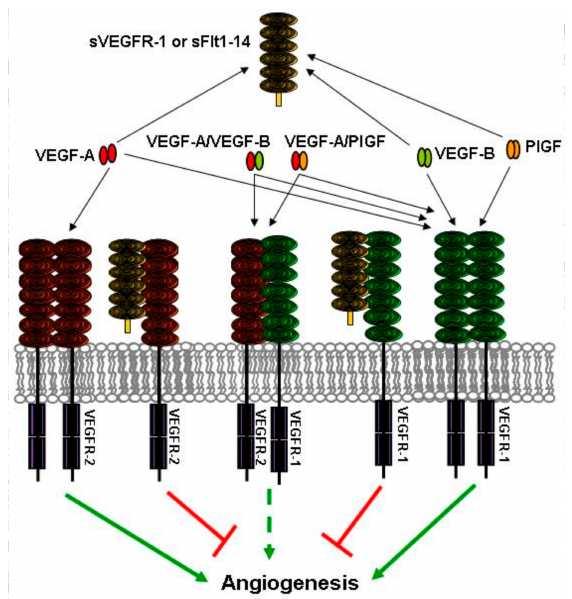
Figure 1. Anti-angiogenic roles of soluble vascular endothelial growth factor receptor (VEGFR)-1 VEGFR-1 isoforms. Soluble VEGFR-1 isoforms, either sVEGFR-1 or soluble fms-like tyrosine kinase (sFlt)1-14, act as “VEGF sinks”. By binding members of the VEGF family, they decrease the amount of growth factors available to interact with the transmembrane tyrosine kinase receptors. In addition, soluble receptor isoforms can reduce VEGF signal transduction by binding to transmembrane receptor monomers and blocking formation of signaling competent receptor homodimers. Receptor heterodimers can also be inhibited by soluble isoforms, thus blocking the signaling of VEGF-A/placenta growth factor (PlGF) or VEGF-A/VEGF-B heterodimers. Interactions that lead to and hamper angiogenesis are indicated by green and red arrows/lines, respectively. The dashed arrow indicates the limited pro-angiogenic activity of receptor